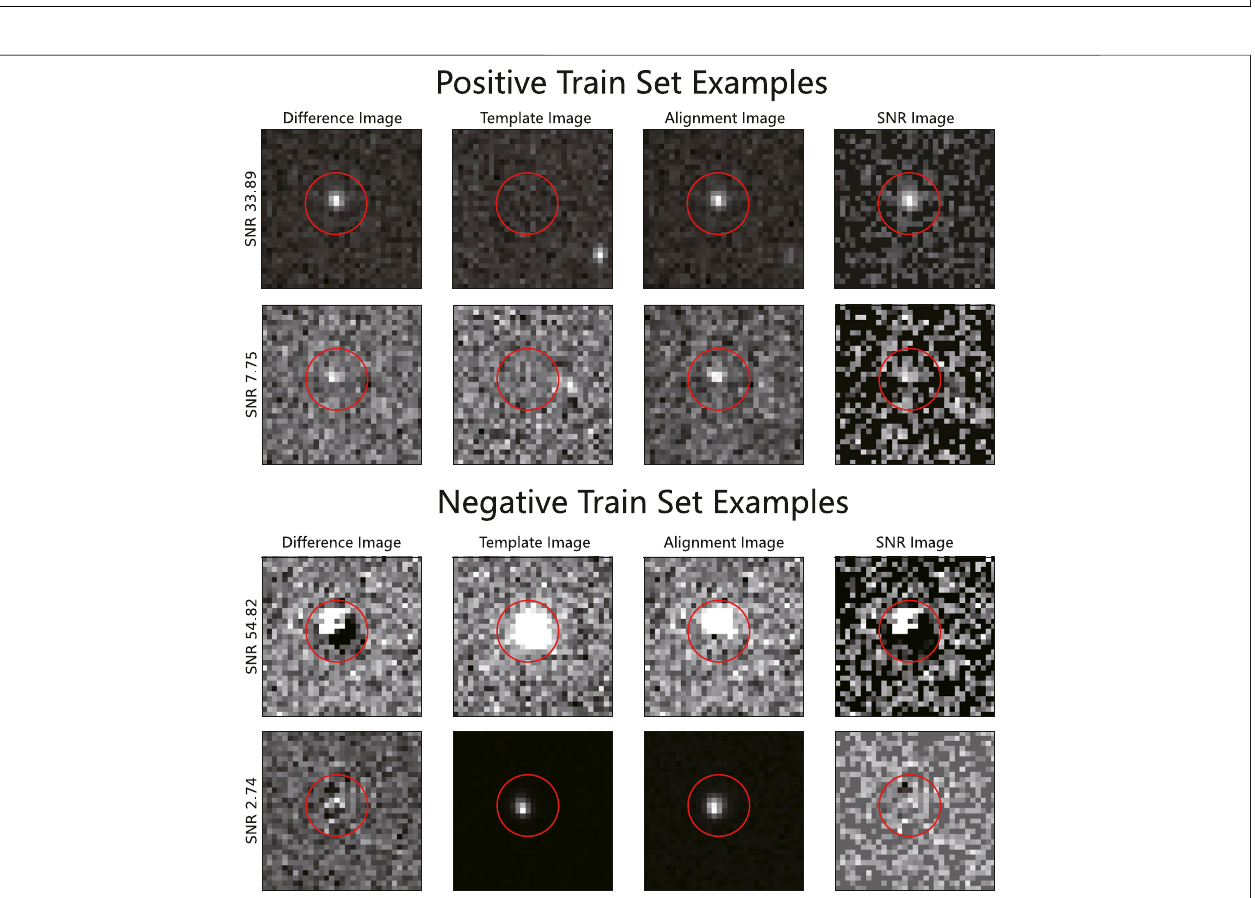
FIGURE 11 | Examples of source samples for the positive and negative candidates used for training the neural networks.